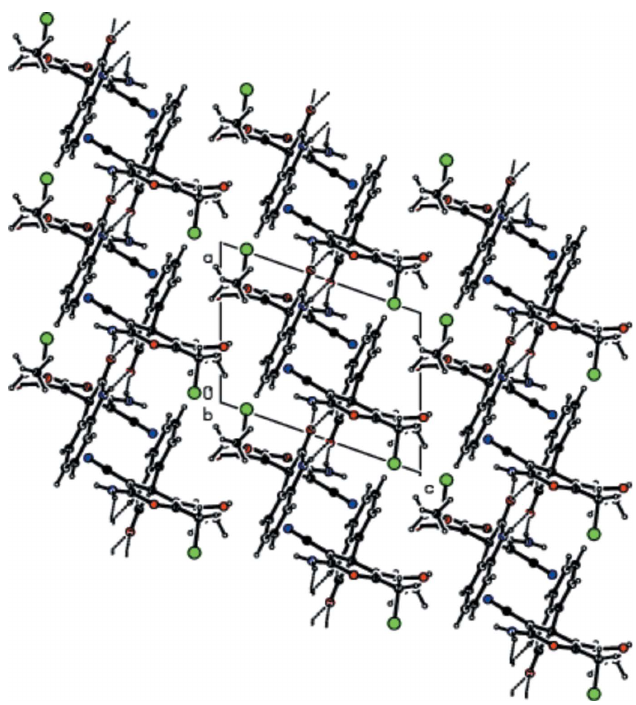
Figure 4 A view of the intermolecular N—H (cid:2)(cid:2)(cid:2) O and C—H (cid:2)(cid:2)(cid:2) N hydrogen bonds in the crystal packing of the title compound down the b axis.